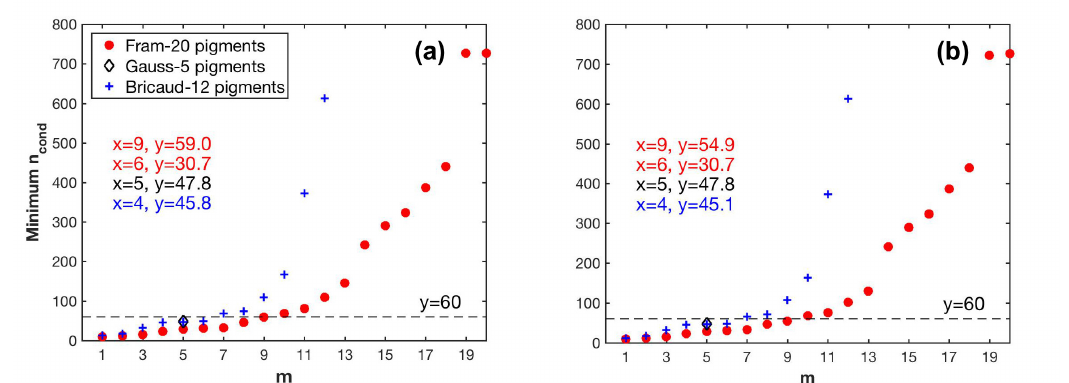
Figure 6. Variations in the minimum values of the condition number ( n cond ) of matrix C in Equation (4) with different pigment combination ( m pigment types to be estimated): ( a ) pigment data unperturbed; ( b ) pigment data